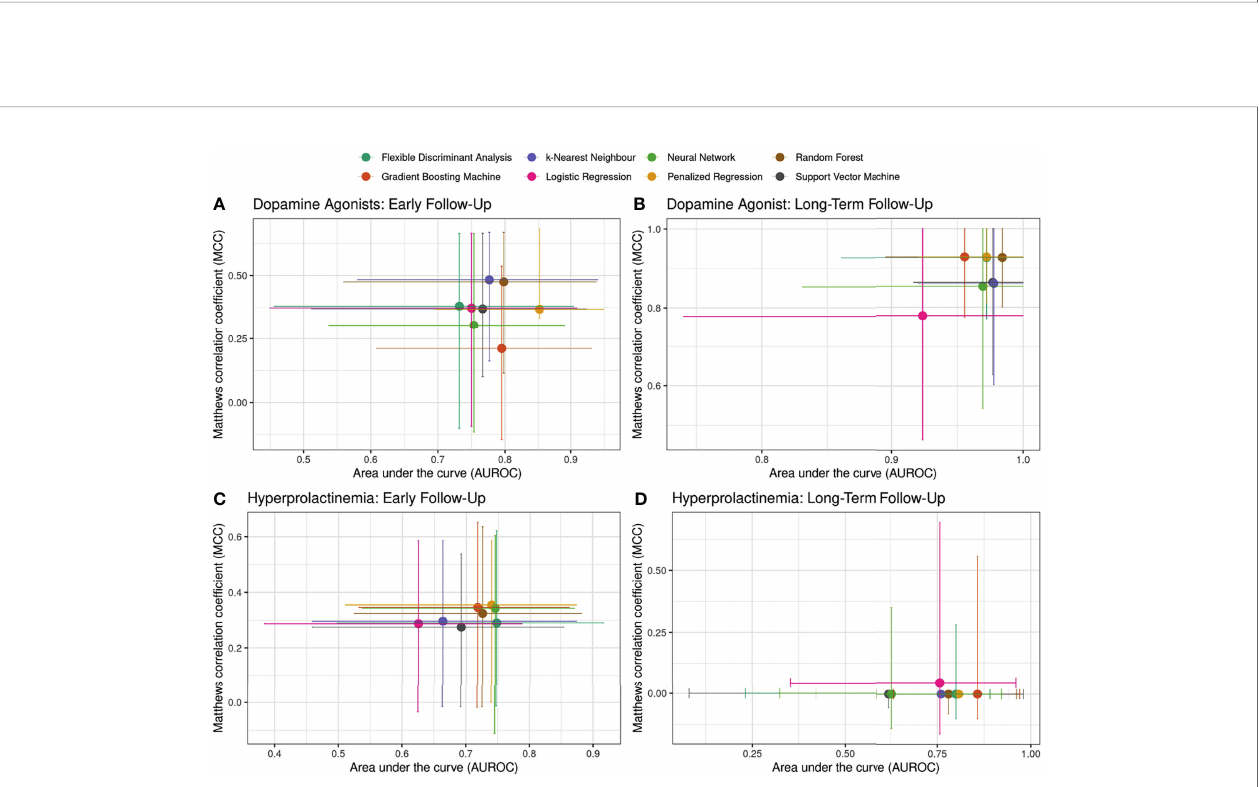
FIGURE 3 | Area under the curve (AUROC) and Matthews correlation coef fi cient (MCC) values for the outcomes at early- and long-term follow-up. Median and 95% con fi dence intervals are shown, where the latter were derived in a repeated cross-validation sampling (three-fold, 100-repeats). For each machine learning algorithm, two in fl uential hyperparameters (refer to Figure 1 ) were sampled 100 times and the hyperparameters settings resulting in the best AUROC performance were